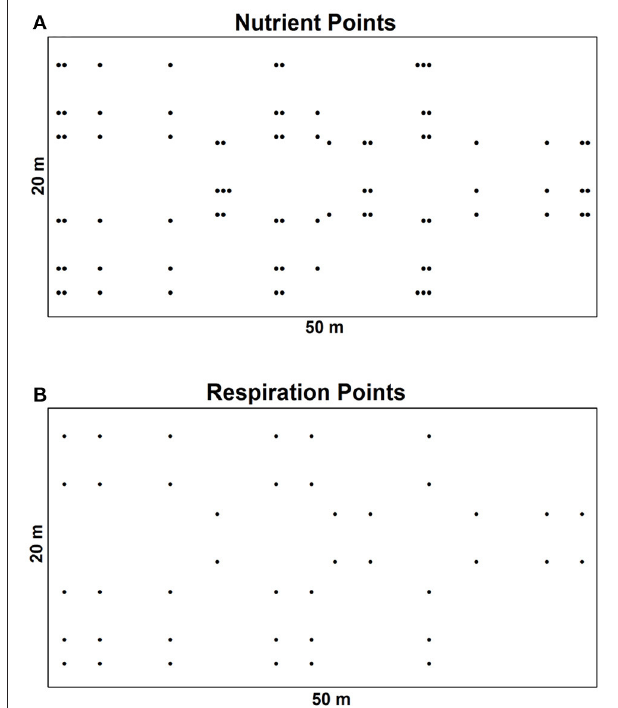
FIGURE 2 | Spatial sampling protocol for data collection during the growing season of 2013 in sites in the Athabasca oils sands region. (A) Design for measurement of bioavailable nutrients with 81 sampling points. (B) Design for measurement of soil respiration with 42 sampling